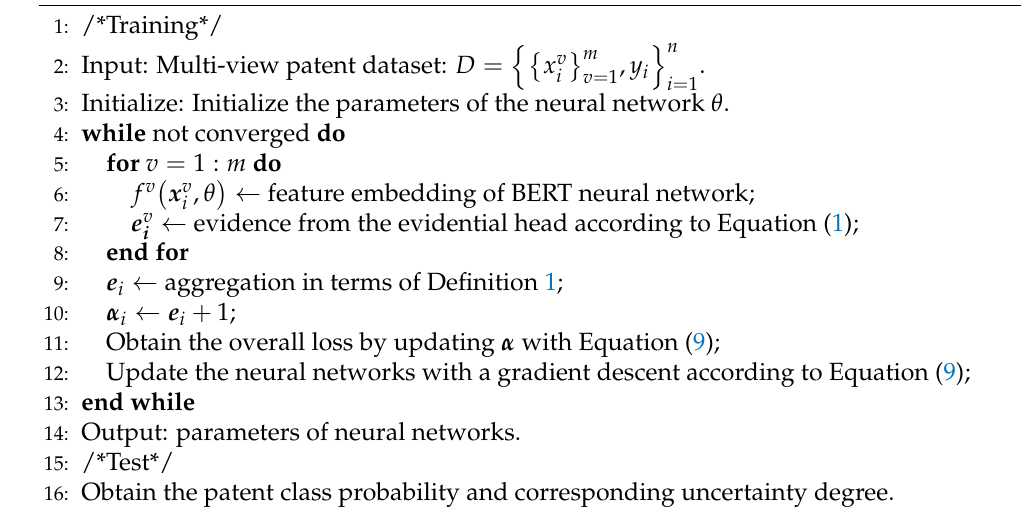
Algorithm 1 Algorithm for Reliable Multi-view Deep Patent Classification